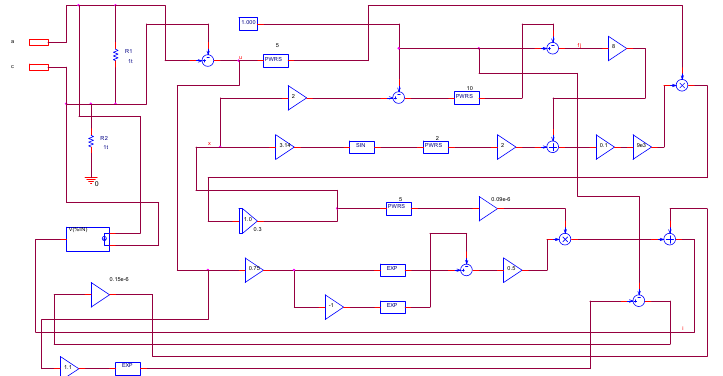
Figure 3. A PSpice schematic of the memristor model (13) with the Joglekar modified window function.